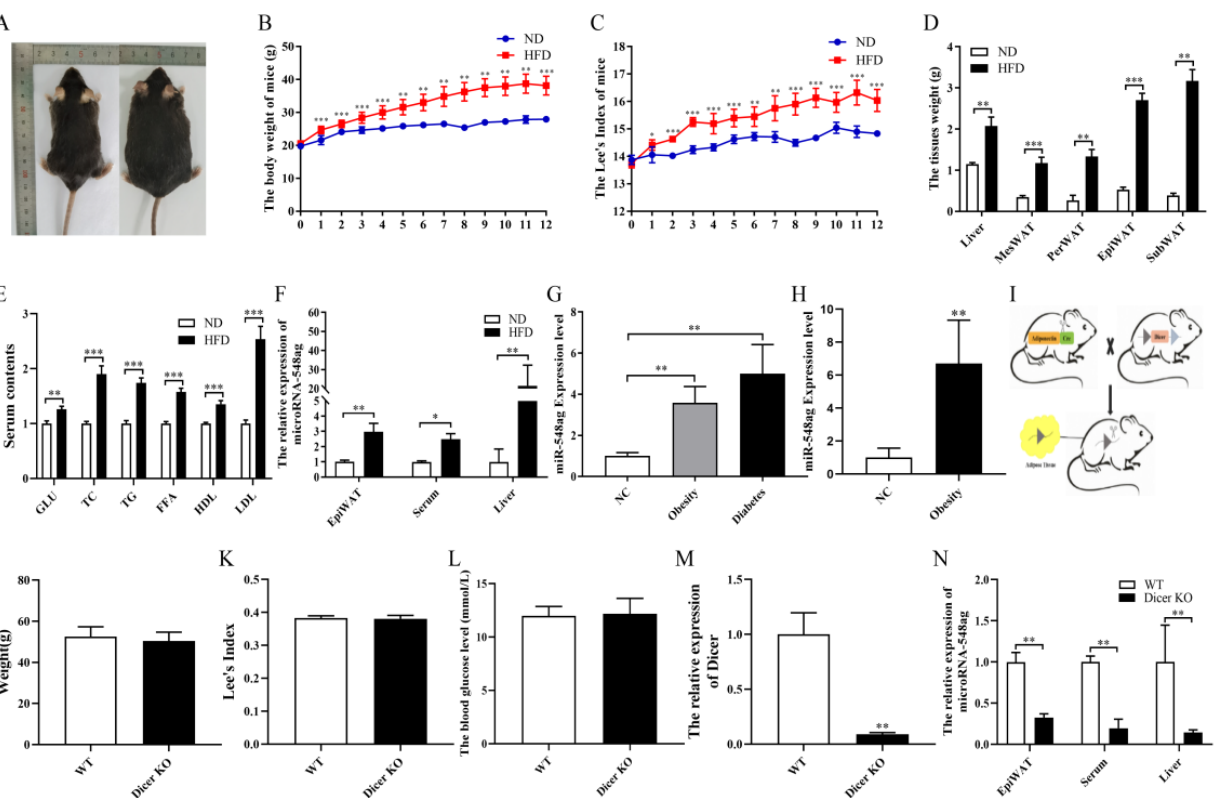
group individuals (Figure 1H). In addition, the levels of serum miR-548ag were positively correlated with BMI, FPG, TG, TC, LDL, and HDL (Supplementary Table S2).